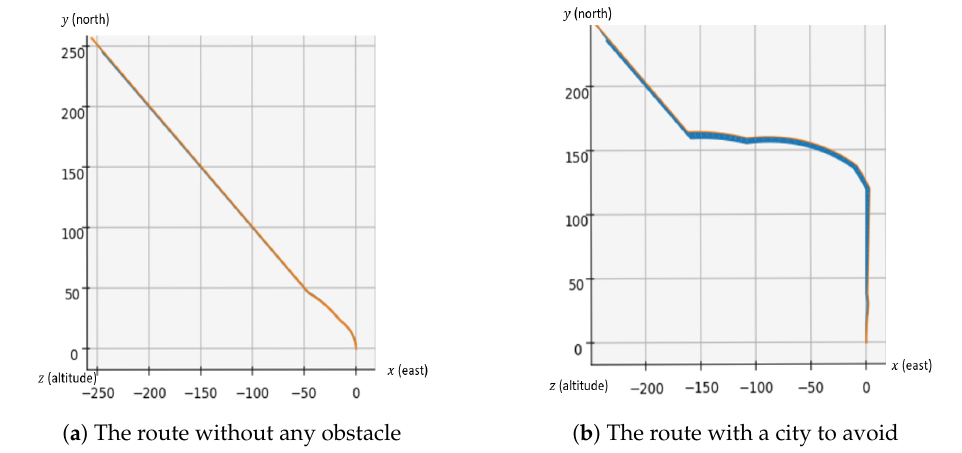
Figure 12. The effects of a city on the route